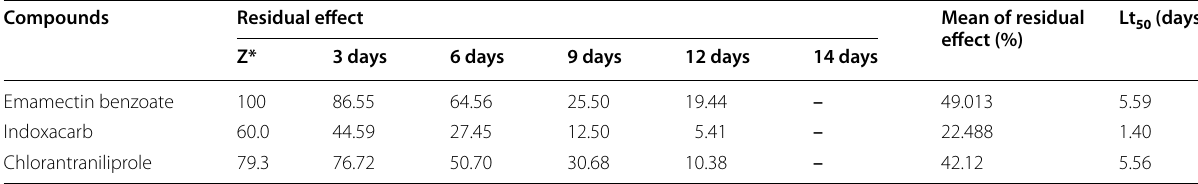
Z * : initial effect (%) at zero time